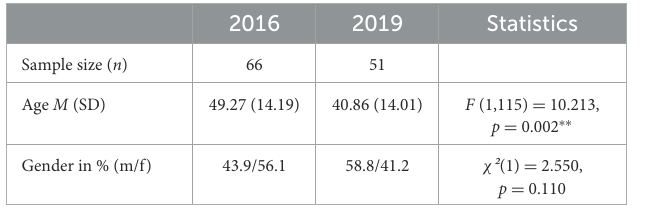
TABLE 2 Sample characteristics of patients with schizophrenia spectrum